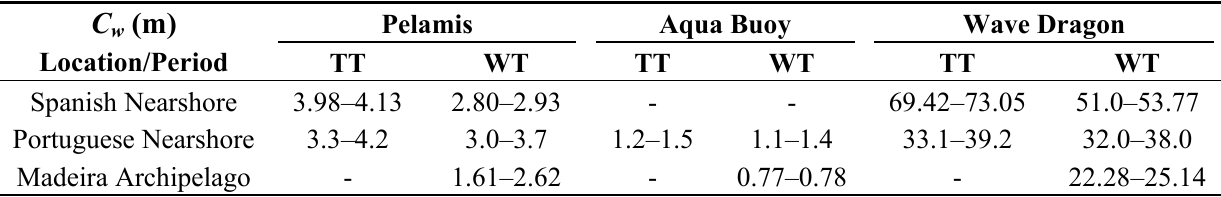
Table 10. Average values of the capture width C (Spanish and Portuguese) and in Madeira archipelago. The WECs considered are Pelamis, Aqua Buoy and Wave